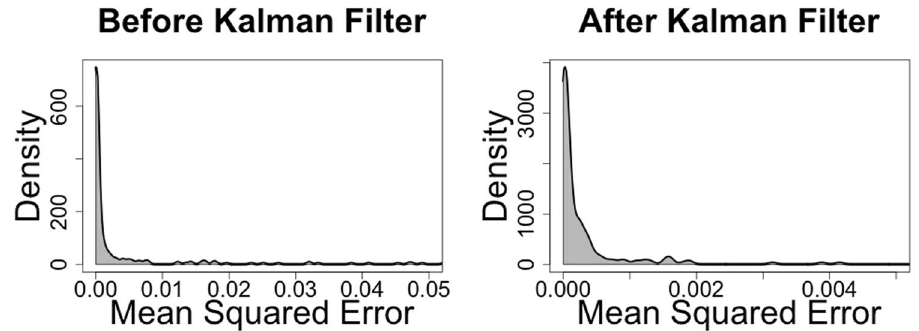
Figure 6. Kalman filter performance. Mean squared error (msr) between the summarized daily drift rate (SDDR) and the observed daily drift rate (ODDR) across all observations (n = 1126). ( A ) Before the use of the Kalman Filter (mean ± SD = 0.005 ± 0.014, upper 95% CI = 0.04), and ( B ) after the Kalman Filter’s application (mean ± SD = 0.0002 ± 0.0006, upper 95% CI = 0.0015). Note the order of magnitude reduction on the x-axis scale in ( B ).